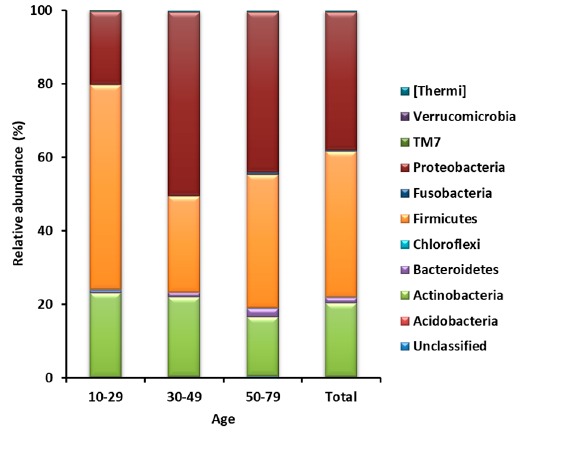
Table 1. Di ff erentially abundant taxa among age Table 1. Differentially abundant taxa among age groups.